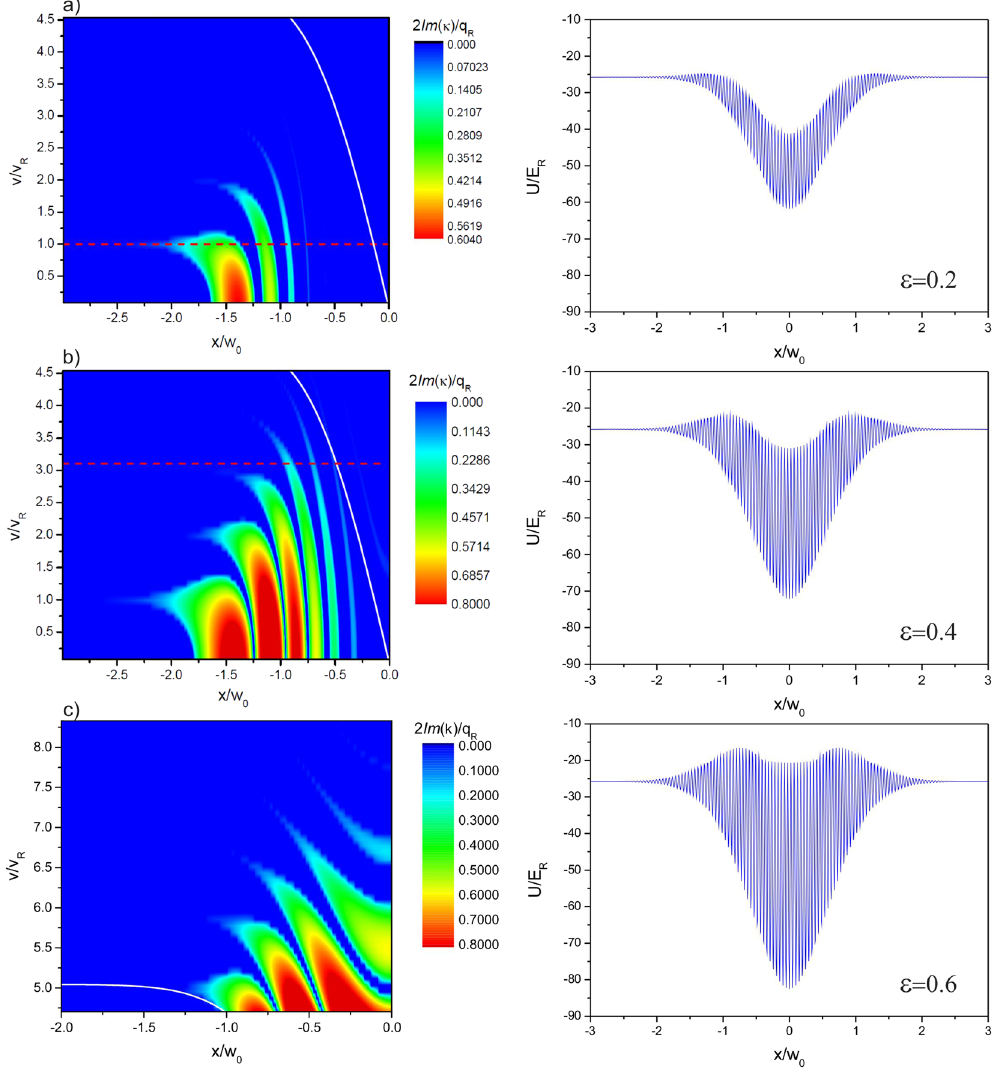
Figure 2. Imaginary part of the Mathieu characteristic exponent calculated along the x axis for different initial velocities of the atomic wavepacket and different lattice strengths. Atoms propagating towards the crossing region move from negative to positive values of x / w 0 in this picture. The calculations refer to our experimental 2 2 . ( a ) For ε = 0.2 atoms with velocity v ≲ v parameters with λ = 1064 nm,  U E 25 and  = E k m /(2 ) R t R R R (highlighted with a red dashed line) are most probably deflected by the lowest energy band opening at a distance ~1.4 w 0 from the center. ( b ) With ε = 0.4, higher order band gaps, opening progressively closer to the centre, deflect the atoms at velocities higher than v R . The solid white line in the graphs shows for each position x